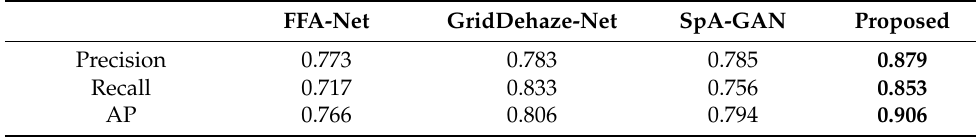
Table 7. Comparison of each model on the high-level noisy image.